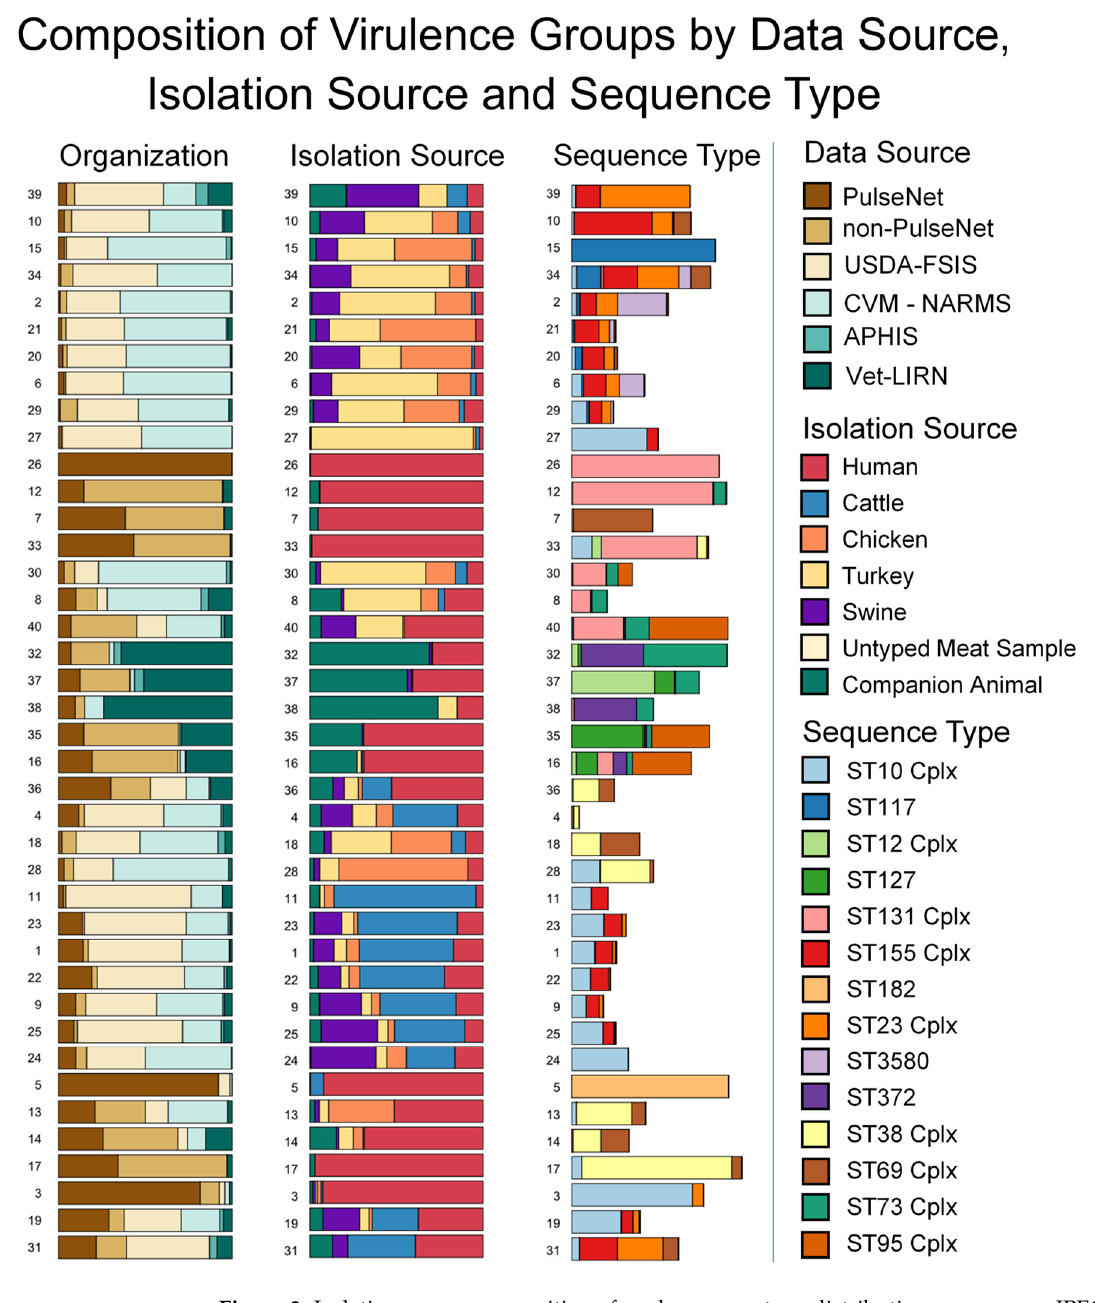
Figure 3. Isolation source composition of, and sequence type distribution among, non-IPEC virulence groups. Cplx designation of sequence type indicates a clonal complex. Virulence group order is consistent with that in Figure 1, to aid visual comparison. Source data can be found in Supplemental Tables S2–S4. Animal isolation sources are the combined results from all contributing organ- izations.